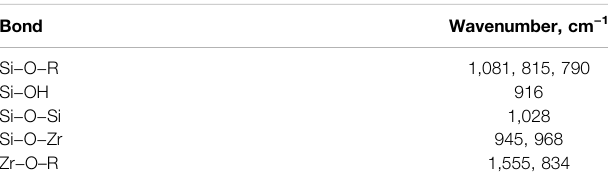
TABLE1| MostcharacteristicbandsintheFTIRspectraforbondsinTMandTMZ sols (Rodi č et al., 2014a, Rodi č et al., 2014b, Rodi č et al., 2016, Rodi č et al.,